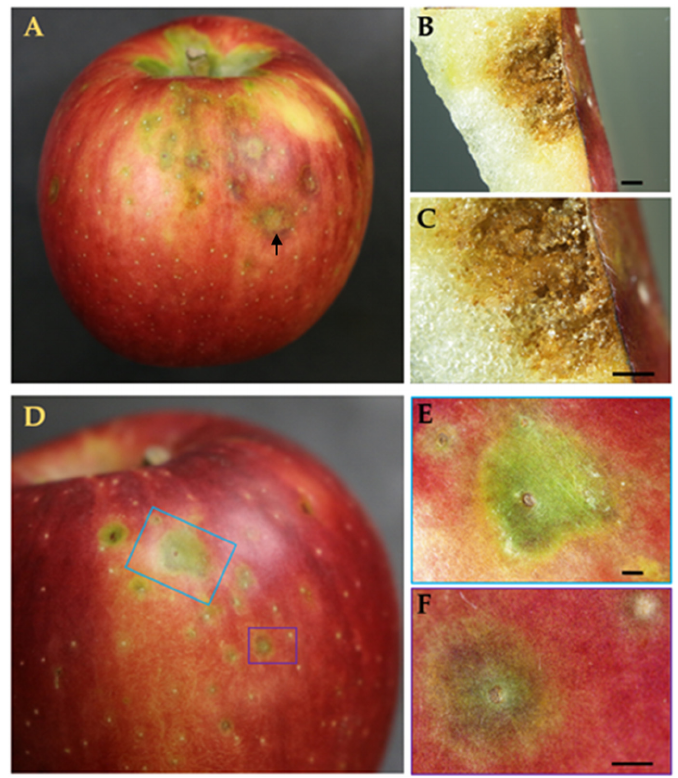
Figure 2. Green spot symptoms on ‘WA 38’ fruit. Example of: ( A ) ‘WA 38’ apple with “severe” GS symptoms visible on the surface and in the underlying parenchyma; ( B ) at 1 × and ( C ) 2 × magnification (black arrow indicates the position of cut for magnified images); ( B , C ) note the darkened, cork-like tissue and areas of collapsed cells; ( D ) green spots centered around lenticels in two different locations on a ‘WA 38’ apple were visualized under ( E ) 1 × and ( F ) 2 × magnification. Whole fruit images ( A , D ) were taken with a Canon EOS 70D DSLR camera, and magnified images were taken with a Nikon SM18 stereomicroscope. Scale bars represent 1 mm at each respective